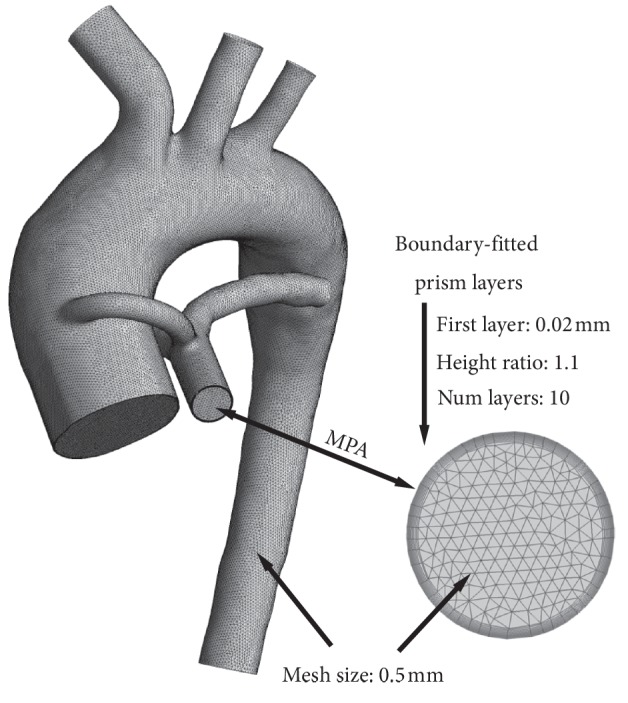
Mesh information.